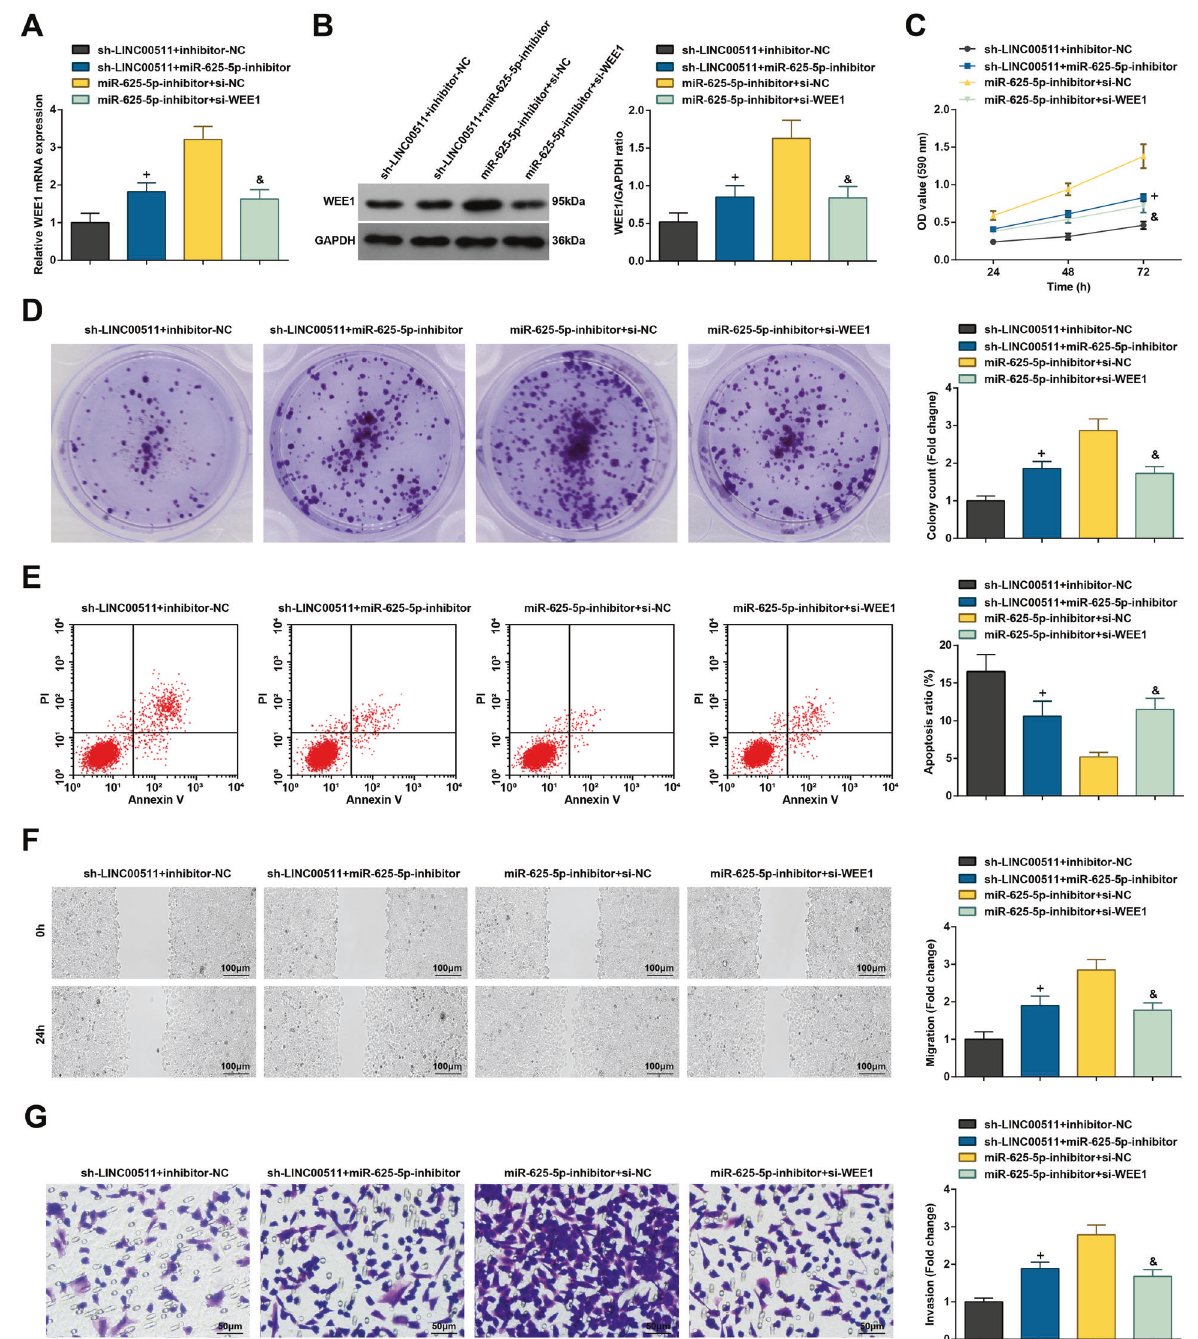
Fig. 7 Silenced miR-625-5p reverses depleted LINC00511-induced effects on CC cells. A RT-qPCR detects WEE1 mRNA expression in CC cells; B western blot assay detected WEE1 protein expression in CC cells; C MTT assay detected viability of CC cells; D colony formation assay detected colony-forming ability of CC cells; E fl ow cytometry detected apoptosis rate of CC cells; F . Scratch test detected migration ability of CC cells; G . Transwell assay detected invasion ability of CC cells; the measurement data are expressed as mean ± standard deviation. N = 3. + P < 0.05 compared with the sh-LINC00511 + inhibitor-NC group; & P < 0.05 compared with the miR-625-5p-inhibitor + si-NC